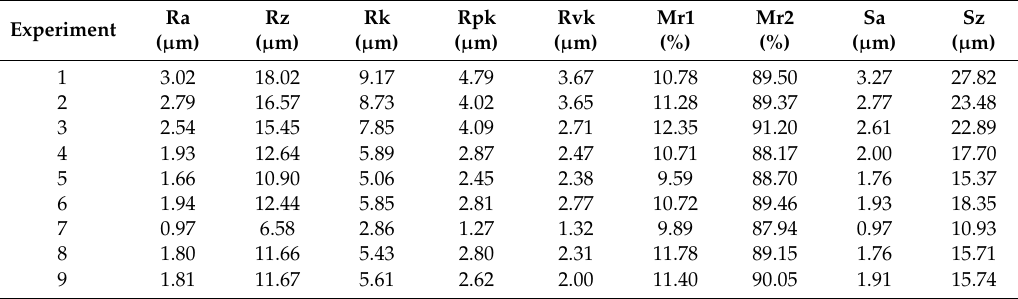
Table 2. Roughness results (average value of each